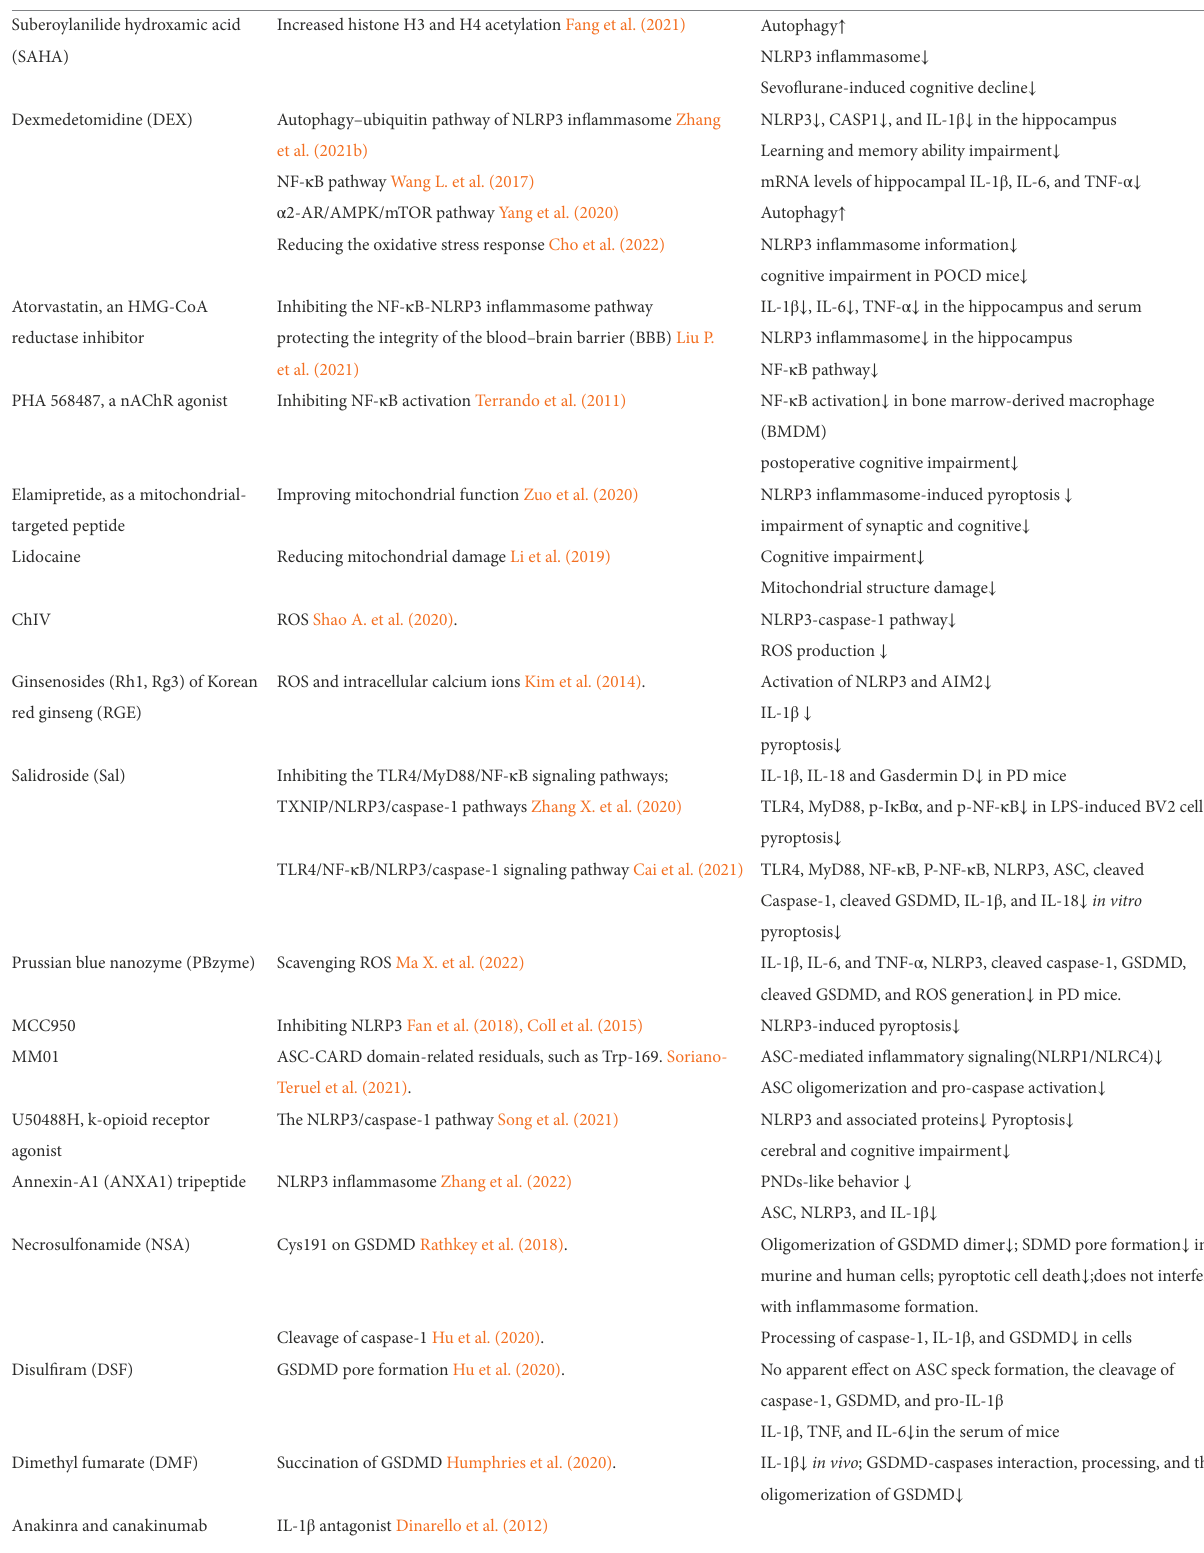
TABLE 1 NLRP3 inflammasome-associated